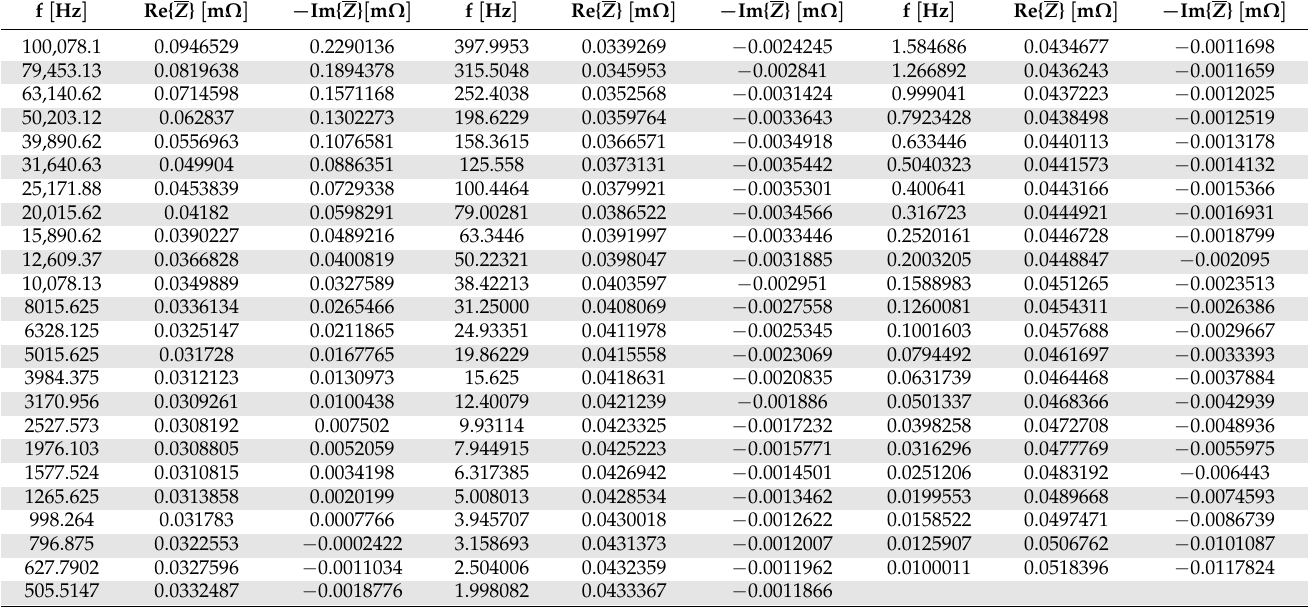
Table A9. EIS data for Murata Sony V3 at an SOC of